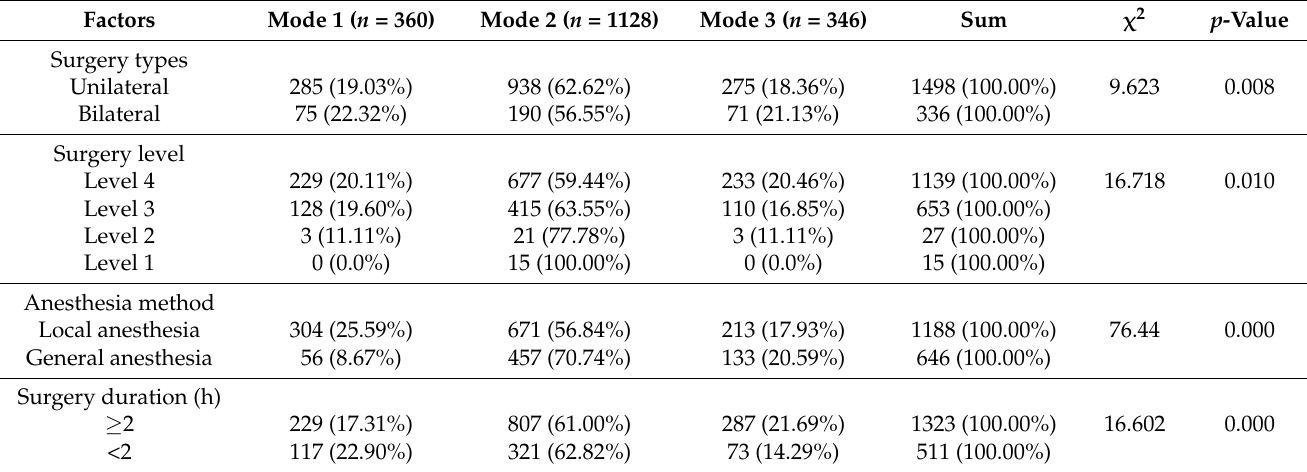
Table 6. Analysis of factors influencing the main mode of